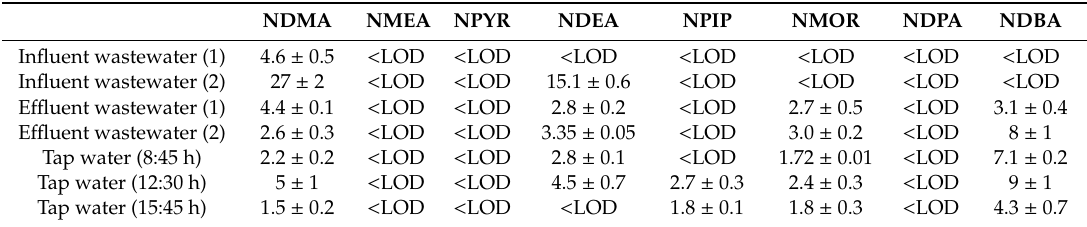
Table 4. Concentrations (ng L − 1 ) ± standard deviation found in real samples collected on two different days (1 and 2). Sampling times are indicated between parentheses for tap water samples collected in the same day. Note: LOD = limit of detection.